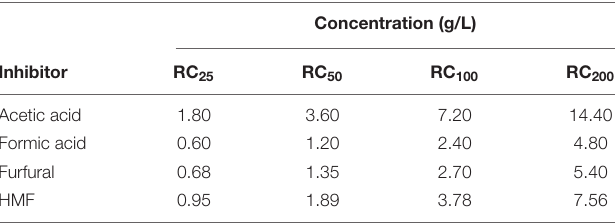
TABLE 3 | Inhibitor composition of four quaternary mixtures used to assess yeast inhibitor